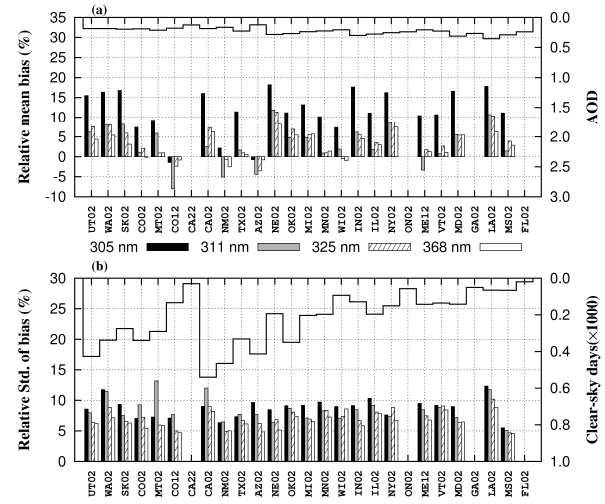
Fig. 6. Same as Fig. 2 except using the L&A (Long and Ackerman [2000]) cloud screening